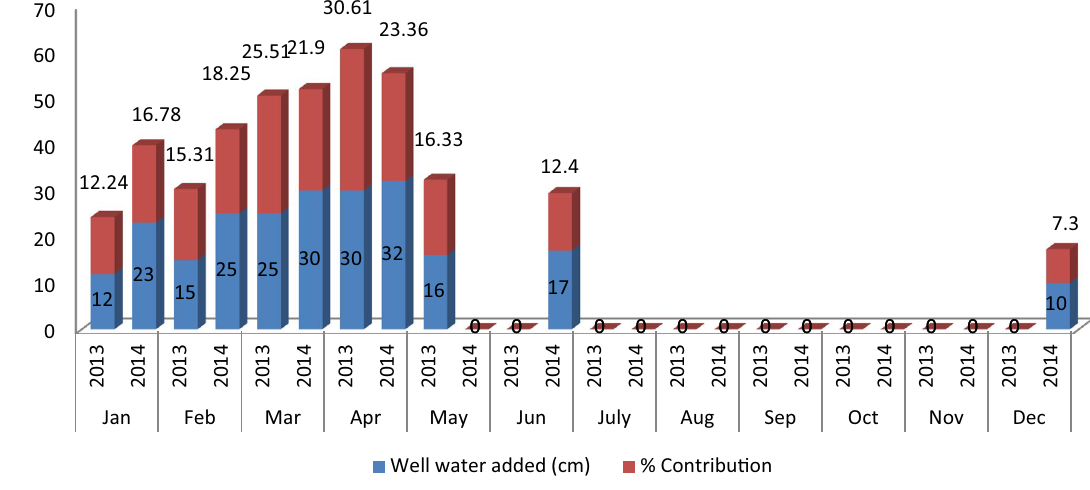
Fig. 8 Total water addition (inflow water) and % contribution to the pond water for each month of 2013 and